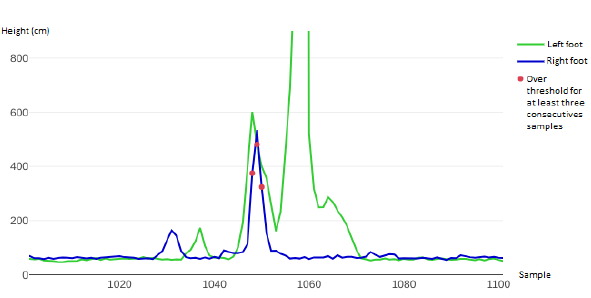
Figure 13. A zoom-in of the third (rightmost) double Lutz of the series of three in Figure 12. After the flying phase, marked by the three red dots and regularly detected as a valid jump, the left foot went parallel to the ground, hence the high green peak reaching the hard limit of the laser sensor, whereas the right foot (blue line) remained on the ground. This scenario corresponded to the exit phase of the element and was not detected as a